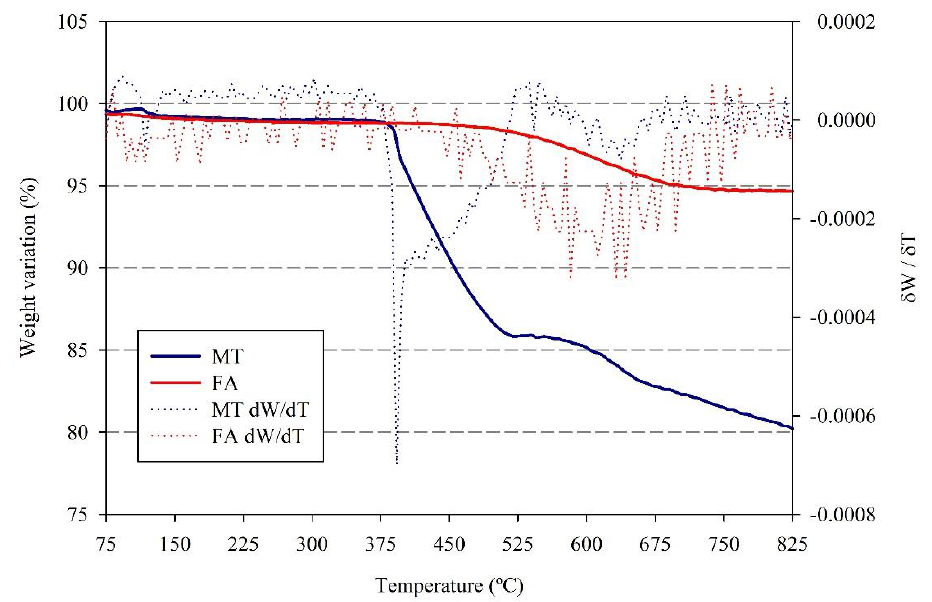
Figure 7. Thermogravimetry and derivative thermogravimetry of the original FA and MT.